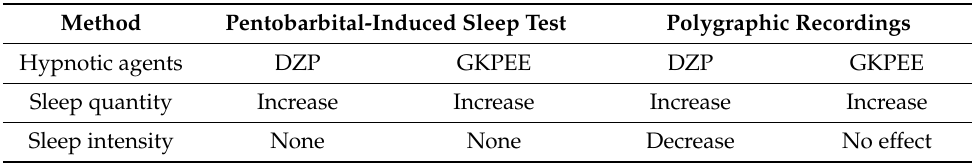
Table 2. Comparison of effectiveness between DZP and